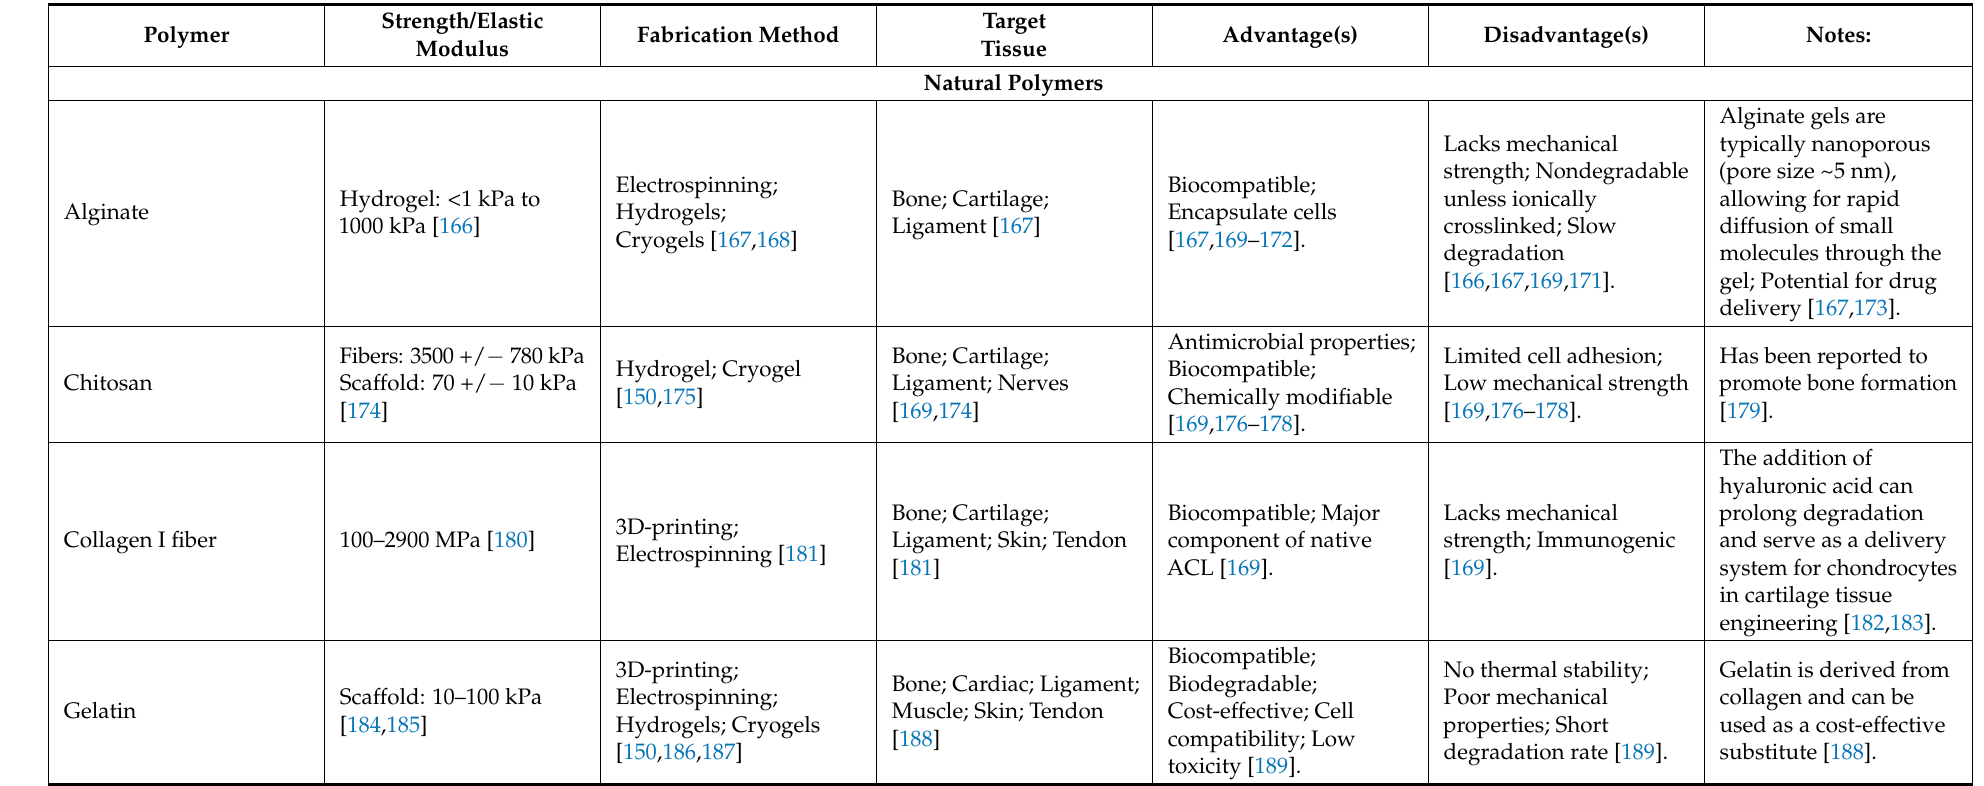
Table 1. An overview of commonly used natural, synthetic, and ECM-derived polymers in tissue engineering, along with frequently used fabrication methods, target tissues, and